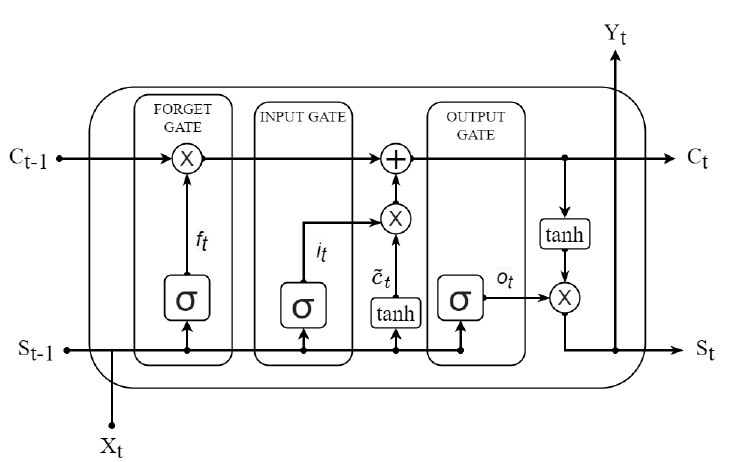
Figure 3. Illustration of Long Short-Term Memory’s